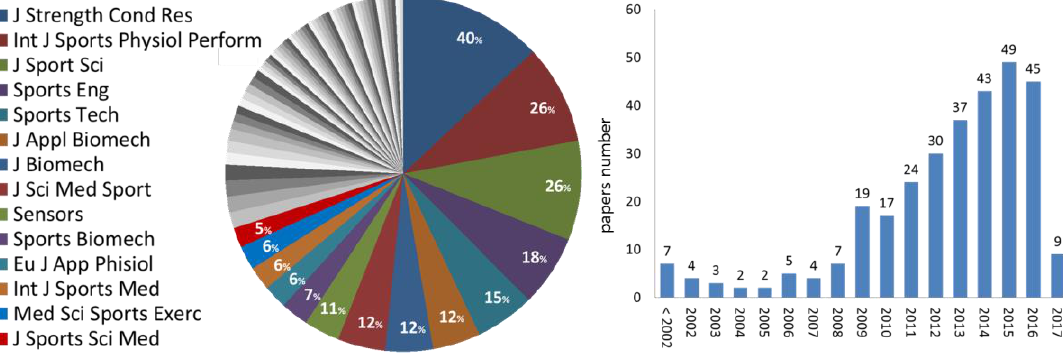
Figure 2. Distribution of the reviews and papers in the systematic review over journals (in %) and time (in absolute values).